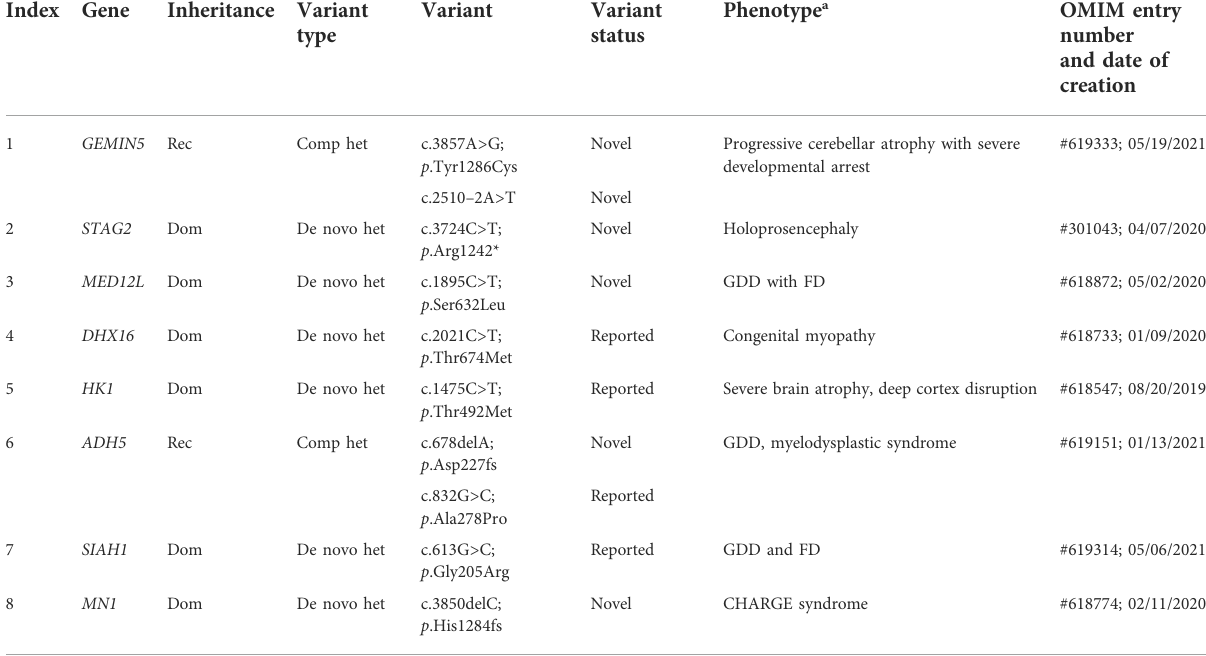
TABLE 1 List of newly diagnosed cases due to new gene entry into